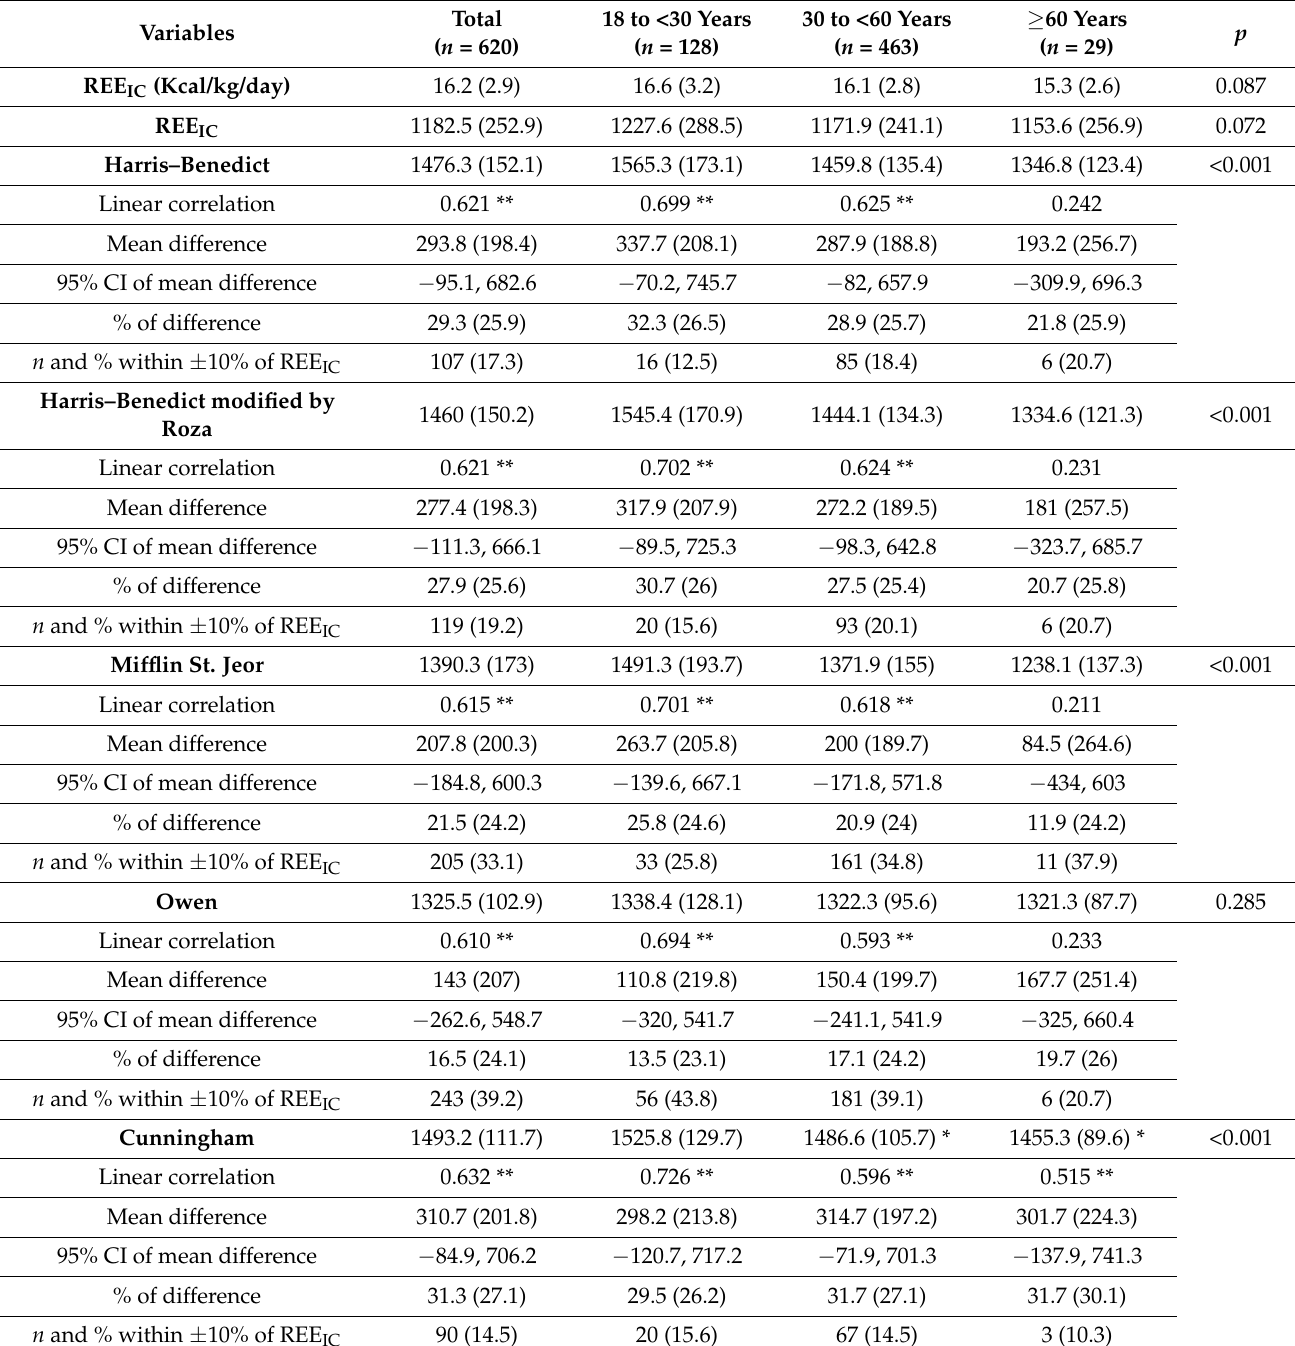
Table 3. Resting energy expenditure (REE) (Kcal/day) by age